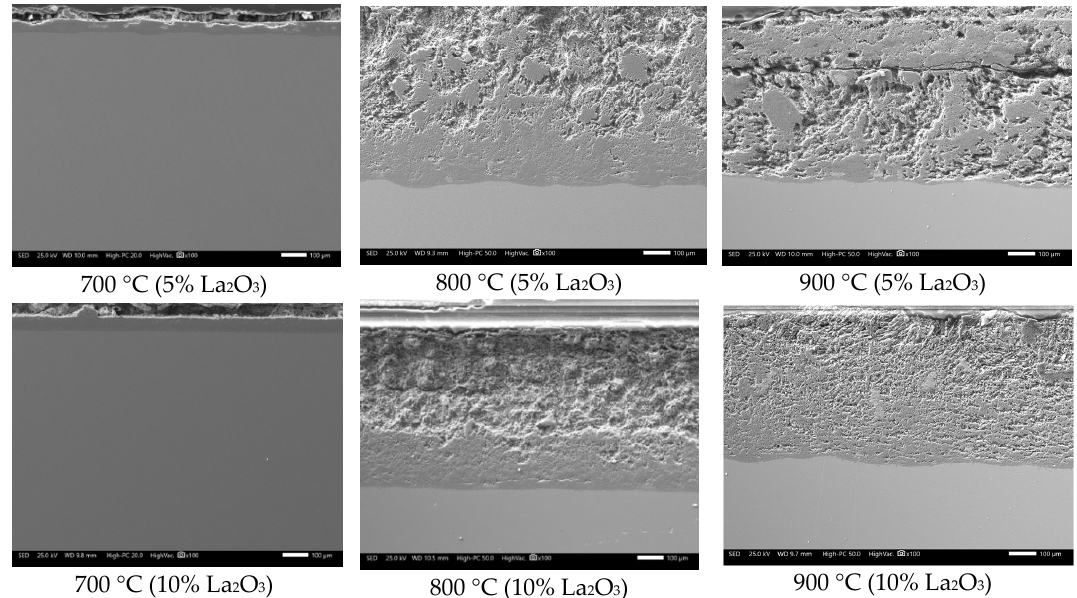
Figure 5. Cross-section appearance of 304H steel after corrosion test for 100 h in NaVO 3 with the addition of La 2 O 3 .